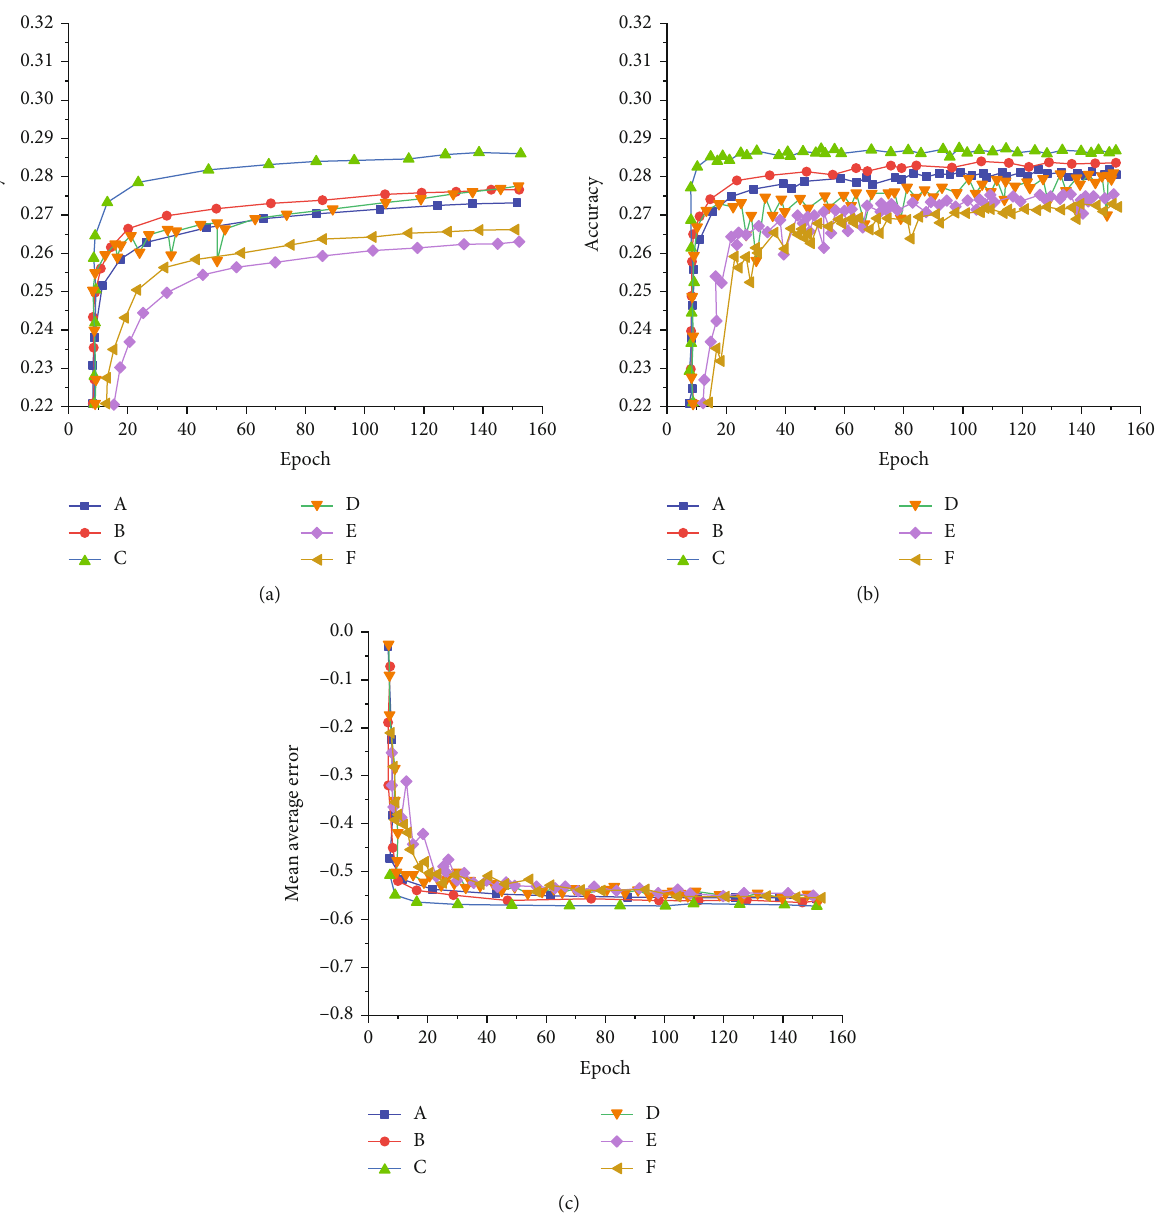
Figure 13: Analysis of the accuracy of employees ’ emotion ((a) training average accuracy curve, (b) veri fi cation of the average accuracy curve, and (c) comparison results of the average error rate under regression loss combination. A: Euclidean distance classi fi cation loss +average absolute error regression loss; B: Euclidean distance classi fi cation loss+variance loss; C: improved focus loss+average absolute error regression loss; D: improved focus loss+variance loss; E: cross-entropy loss+variance loss; F: cross-entropy loss+average absolute error regression